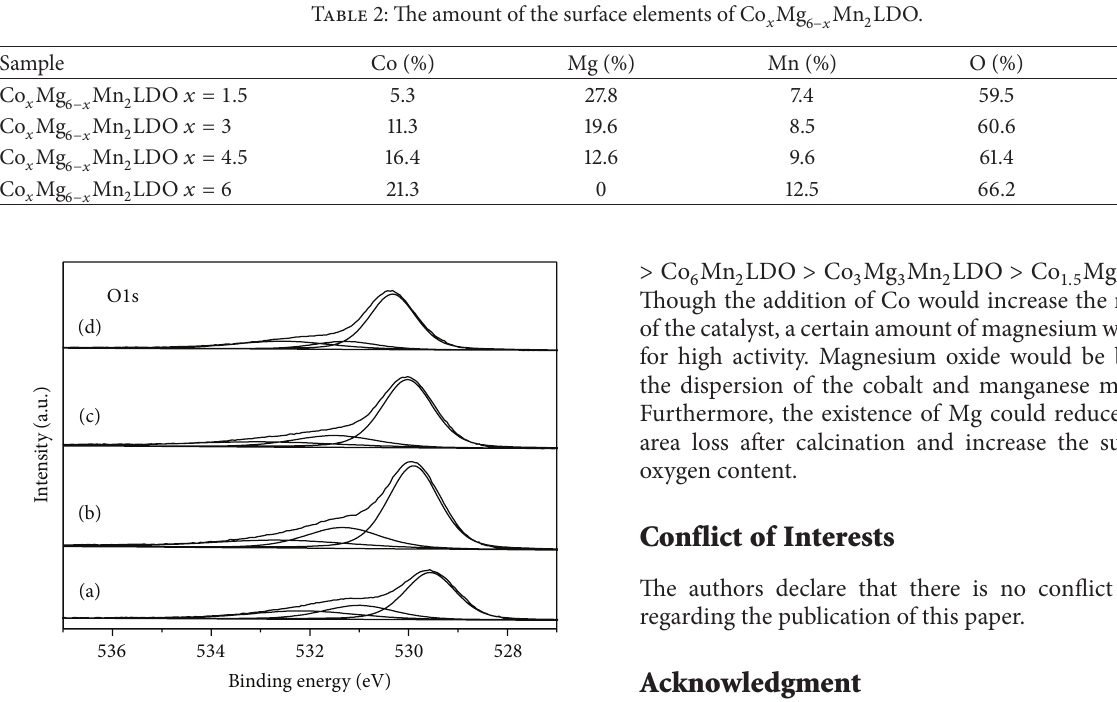
Figure 5: O1s XPS patterns of Co 𝑥 Mg 6−𝑥 Mn 2 LDO samples: (a) 𝑥 =